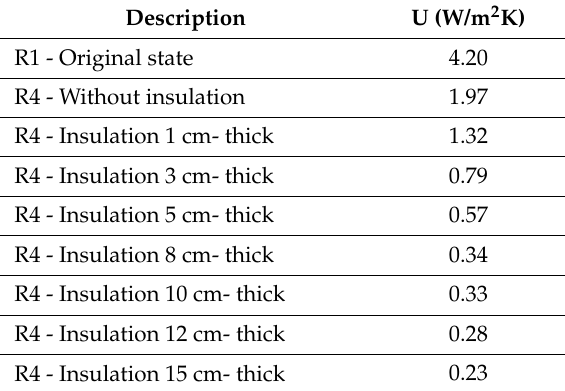
Table 10. Thermal transmittance of roof R4 according to the insulation thickness